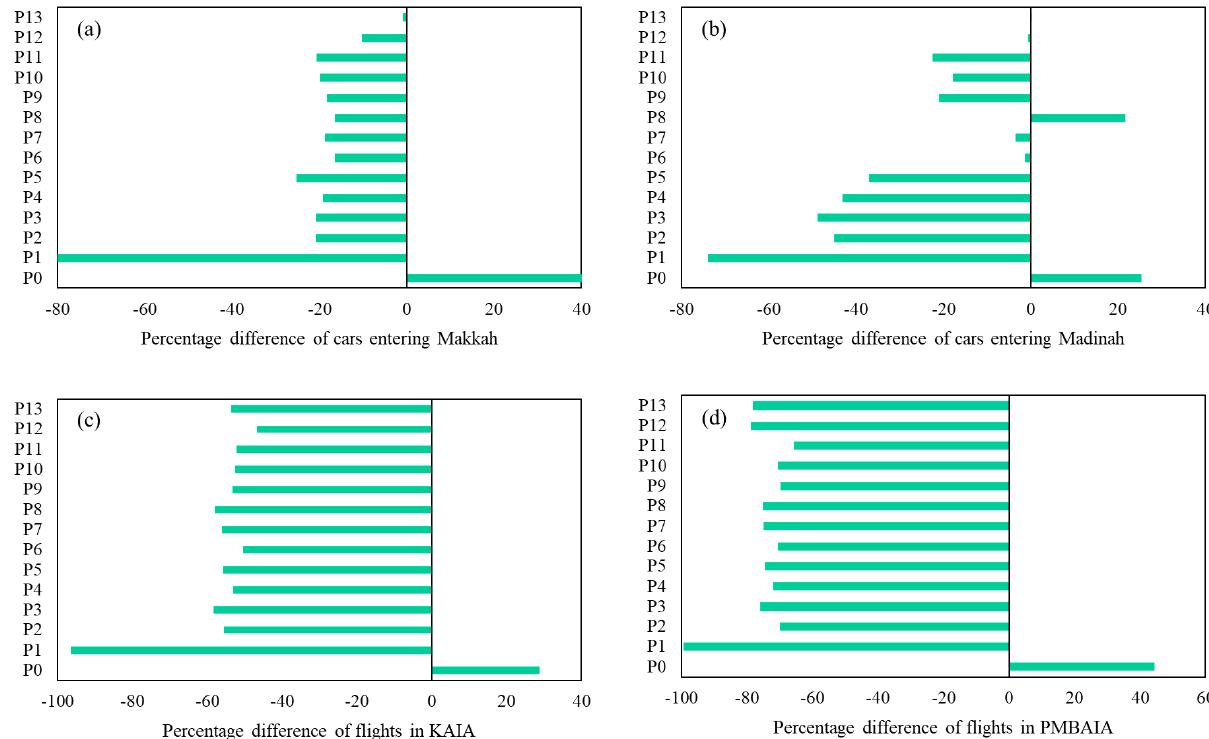
Figure 8. Percentage changes of cars entering ( a ) Makkah; ( b ) Madinah and flights at ( c ) KAIA; ( d ) PMBAIA.